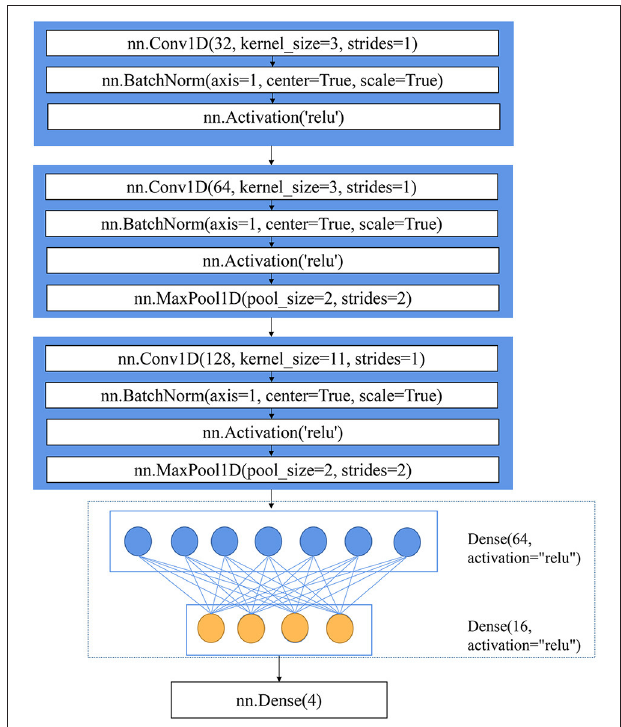
FIGURE 1 | The architecture of CNN.